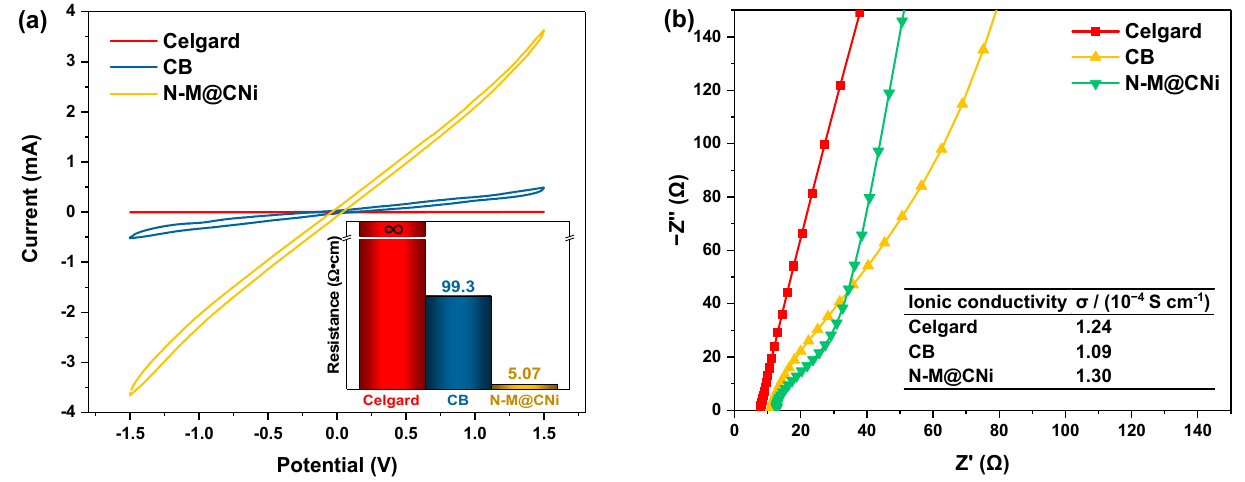
Figure 5. ( a ) The CV of the symmetric cells (coating/Celgard/Celgard/coating) with different separators. The insert shows the resistance of different separators measured by the four-probe method. ( b ) The impedance plots of the stainless steel/modified separator/stainless steel cells with different separators. The inserted table summarizes the calculated ionic conductivity values of the Celgard, the CB, and the N-M@CNi separators.